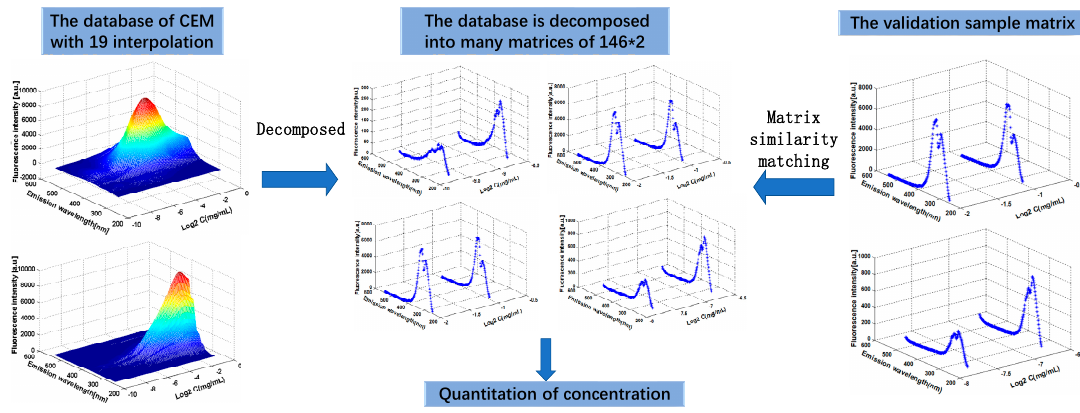
Figure 6. Schematic diagram of the concentration quantification.